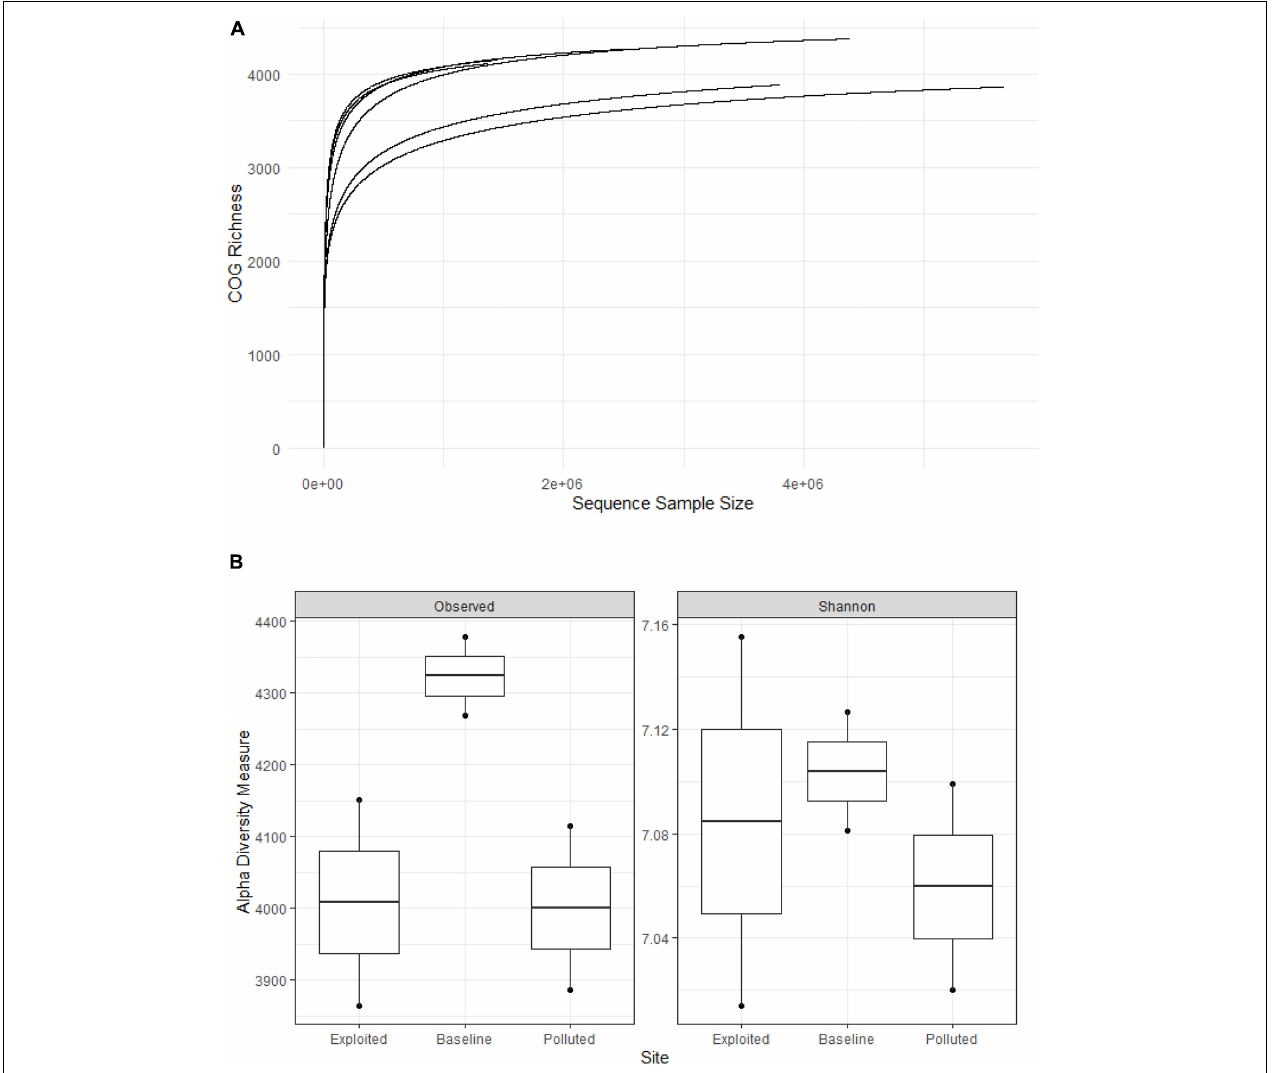
FIGURE 7 | (A) Rarefaction curves and (B) plots of alpha diversity metrics for clusters of orthologous groups of proteins (COG) richness on the near-coral seawater and sediment metagenomes from Kenya reefs on the